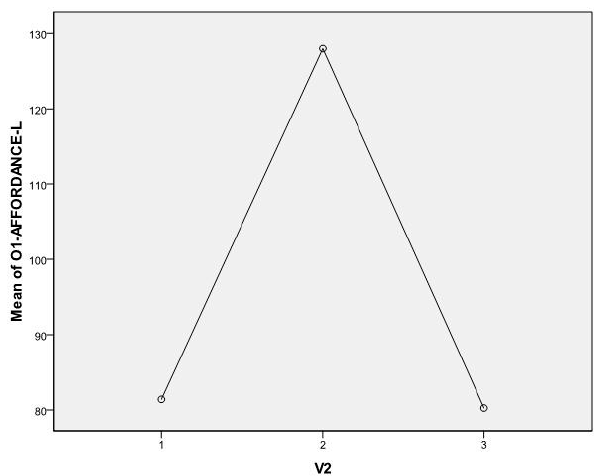
Figure 5. N1 ERP component latency in occipital left lobe: condition 1 (motor imagery), condition 2 (Leap Motion), and condition 3 (haptic manipulation). In the Leap Motion condition N1 latency is slower.